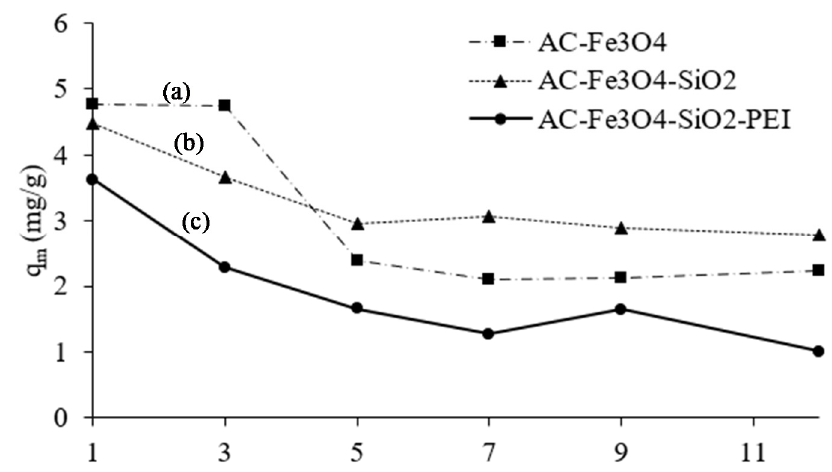
Figure 8. Effect of solution pH on the adsorption of Cr(VI) by AC-Fe 3 O 4 ( a ), AC-Fe 3 O 4 -SiO 2 ( b ), and AC-Fe 3 O 4 -SiO 2 -PEI ( c ). (conditions: 8 mg/L initial concentration 60 min contact time, 0.05 g adsorbent mass, 25 °C temperature and 30 mL solution volume).